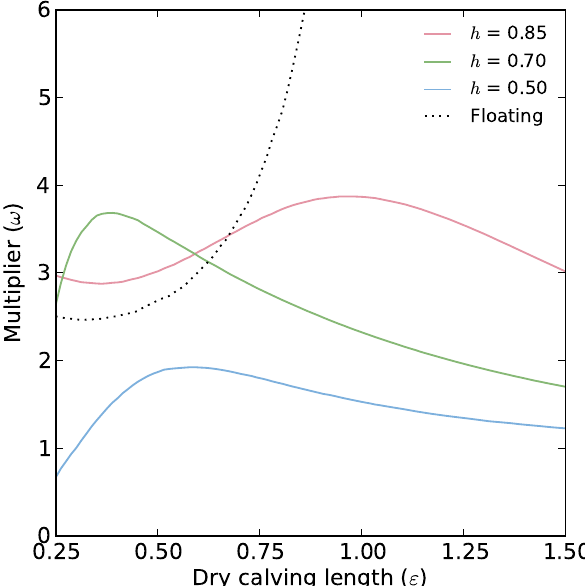
Fig. 5. The effect of a temperature gradient on the ω − ε relationship. Solid lines show the baseline cases, while dashed lines show the re- lationship when a 10 ◦ C temperature gradient is applied. For lightly grounded glaciers, there is a positive effect, while heavily grounded glaciers see almost no